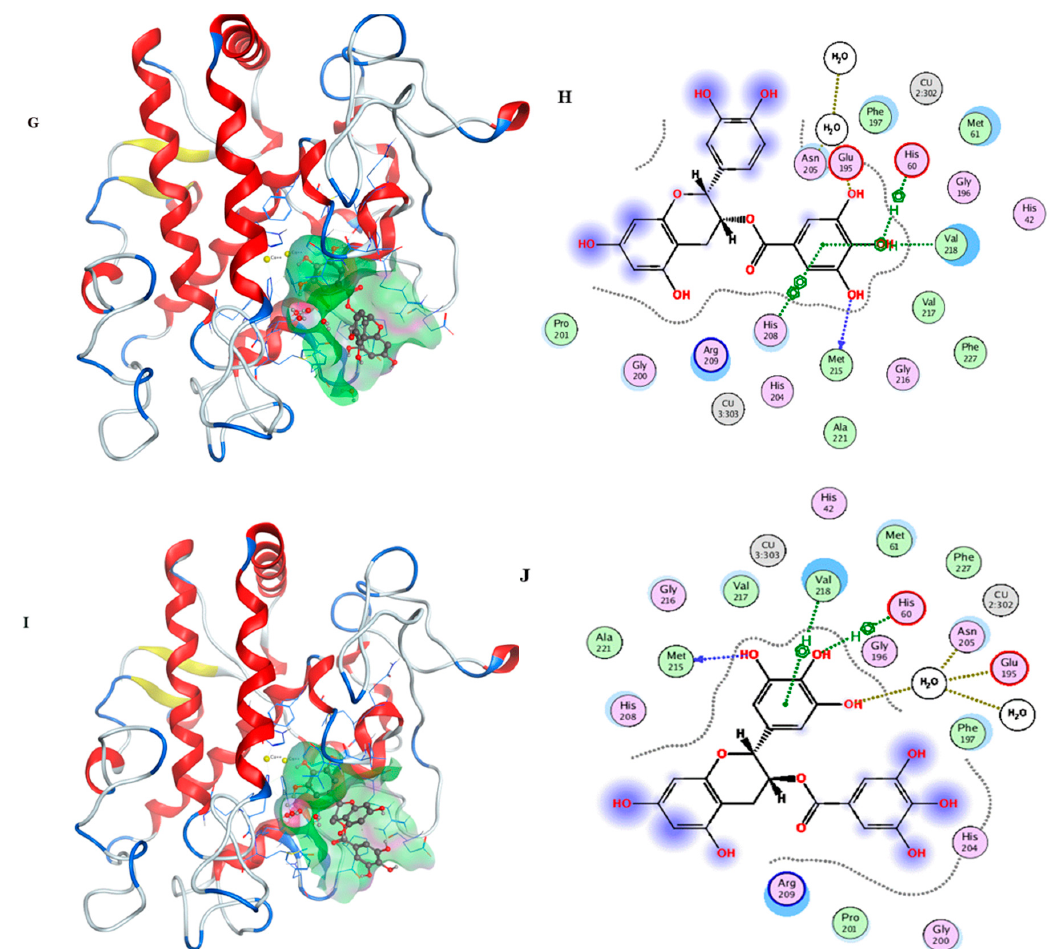
Figure 3. Ligands are shown as grey, site residues are shown as blue, copper ions are shown as yellow. ( A ) binding conformation of LSOPC dimer binding to the tyrosinase; ( B ) molecular contacts between LSOPC dimer and amino acids of tyrosinase; ( C ) binding conformation of compound CC binding to the tyrosinase; ( D ) molecular contacts between compound CC and amino acids of tyrosinase; ( E ) binding conformation of compound EC binding to the tyrosinase; ( F ) molecular contacts between compound EC and amino acids of tyrosinase; ( G ) binding conformation of compound EGC binding to the tyrosinase; ( H ) molecular contacts between compound EGC and amino acids of tyrosinase; ( I ) binding conformation of compound EGCG binding to the tyrosinase; ( J ) molecular contacts between compound EGCG and amino acids of tyrosinase.